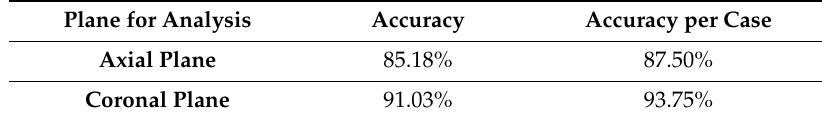
Table 5. Comparison of classification accuracy with the axial plane and the coronal plane (CNN: